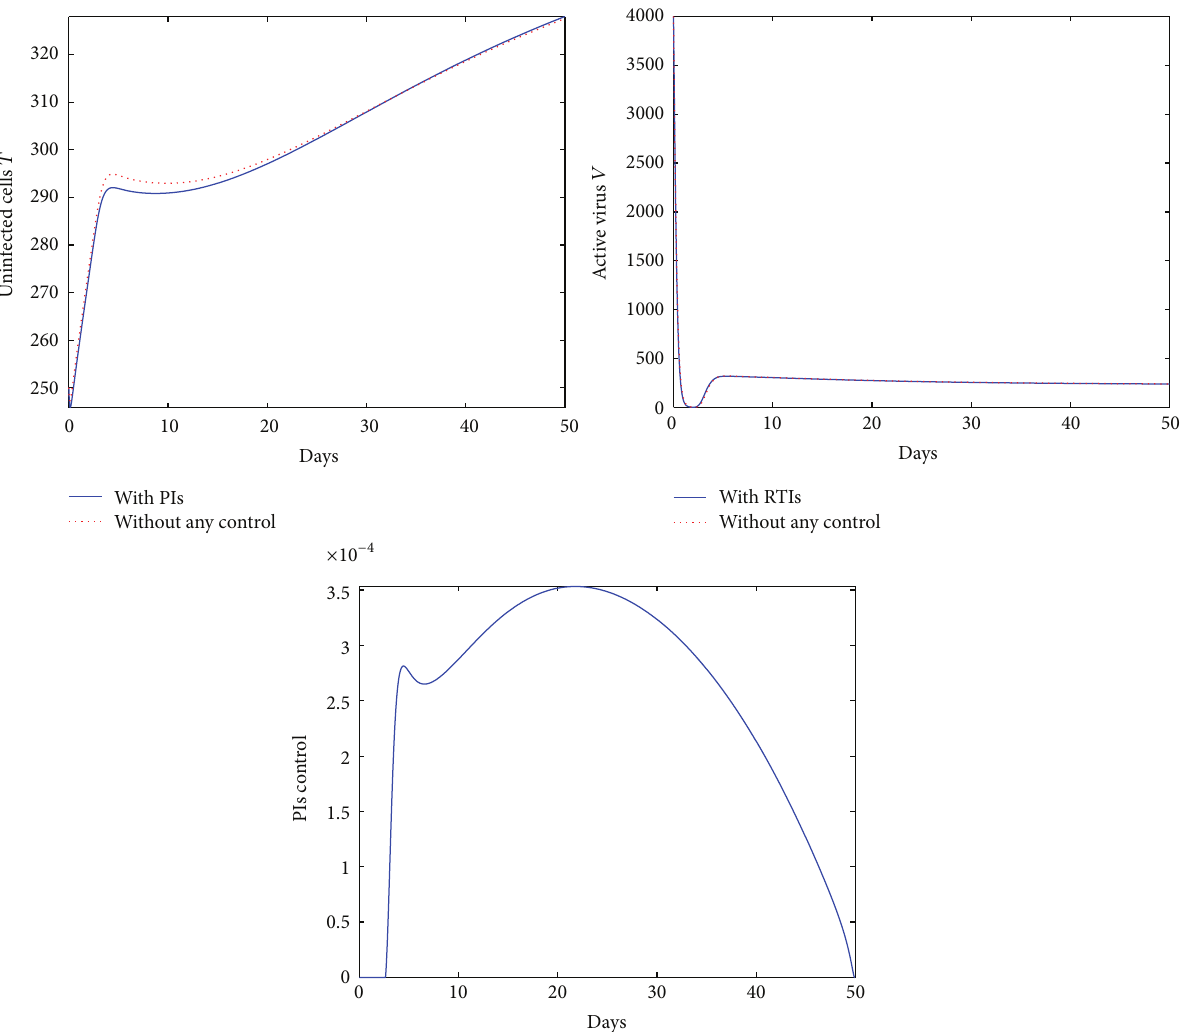
Figure 2: Optimal solutions only using PIs with sufficiently large weight coefficient 𝛼 2 for a 50-day treatment.